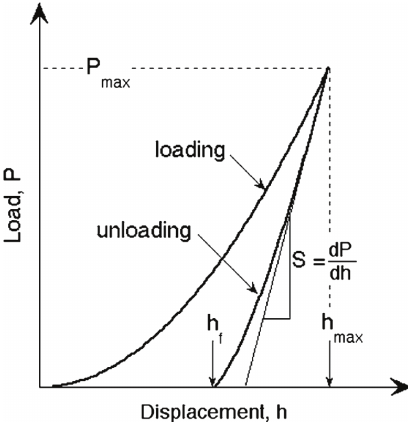
Fig. 2. Theoretical indentation load vs displacement curve